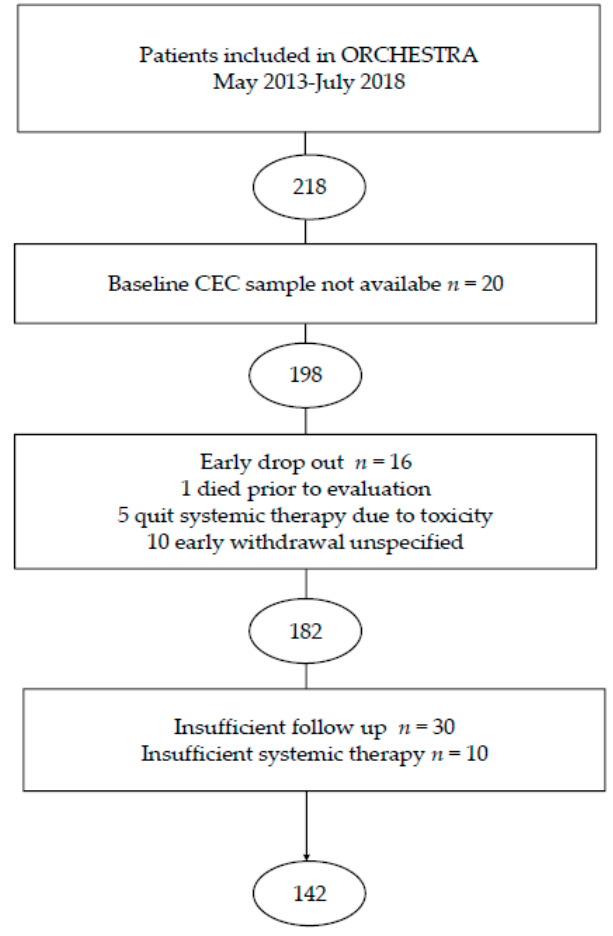
Figure 1. Flowchart of the inclusion of patients for analyses of CECs.